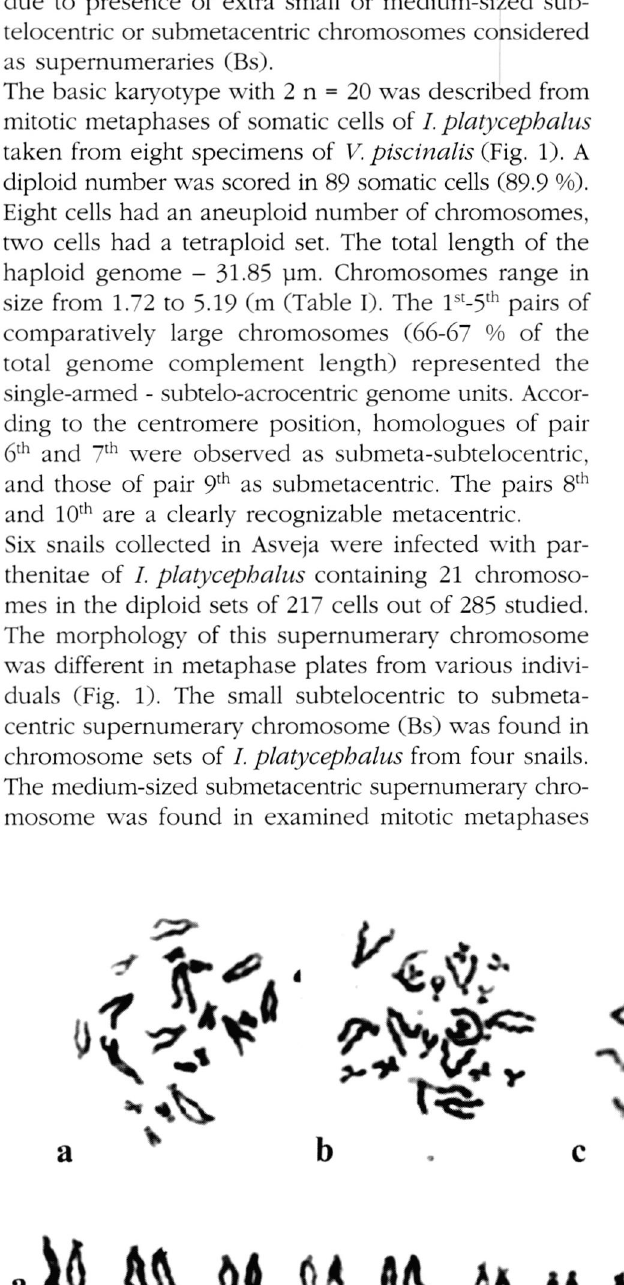
Fig. 1. - Mitotic metaphases and karyo­ types of karyomorphs of Icbthyocoty- hirus platycephalus with 2 n = 20 (a) and 2n=21 (b, c). Scale bar = 10